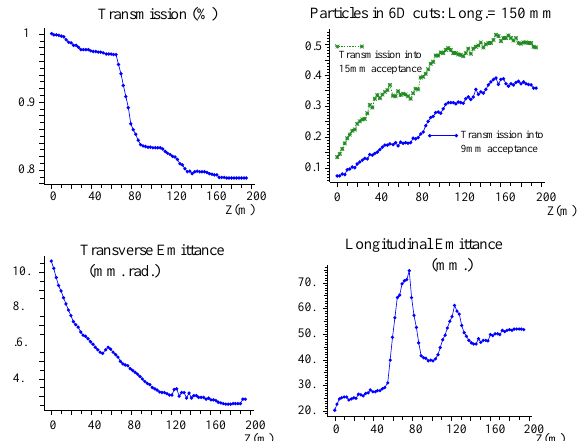
FIG. 10. (Color) Performance of the single flip channel. Top left: fractional transmission; top right: fractional transmis- sion into acceleration acceptance, lower curve (blue) with a 9.375 mm rad transverse cut, upper curve (green) with a 15 mm transverse cut; bottom left: transverse emittance; bottom right: longitudinal